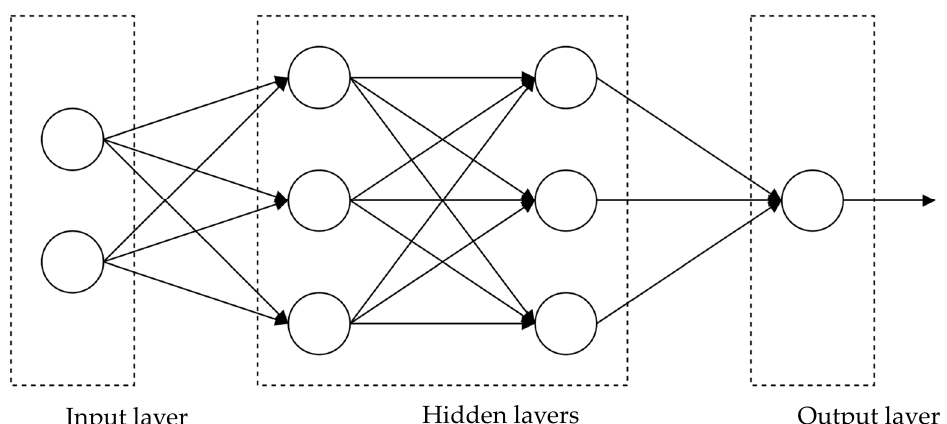
Figure 1. A fully connected NN with one input layer, two hidden layers, and one output layer. Circles represent neurons, which apply activation functions to the total sum of the products of the previous layer’s activation and weight pairs.